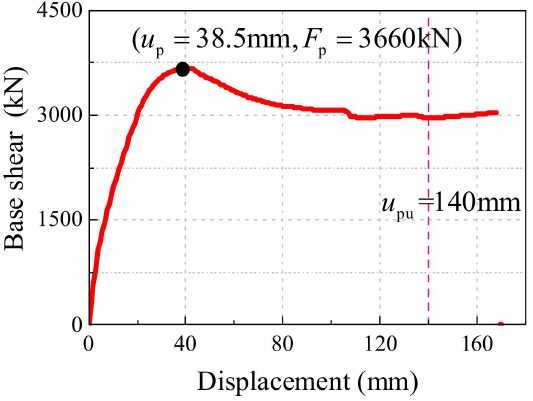
Figure 15. Pushover curve of prototype.